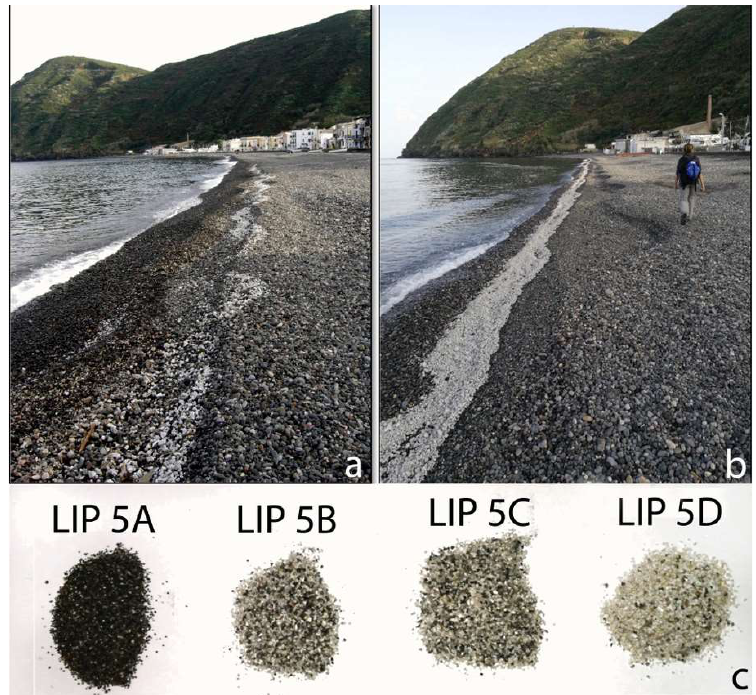
Figure A10. Along the central and southern part of the Canneto beach, pumice fragments are present both as sparse ( a ) and concentrated on the berm ( b ); ( c ) visual comparison of the 0/ − 1 Φ 1(1–2 mm) grain size fraction sampled in the beach foreshore sediment of Canneto beach from north to south (from LIP5A to LIP5D), showing the downdrift enrichment in the lighter pumice fraction.